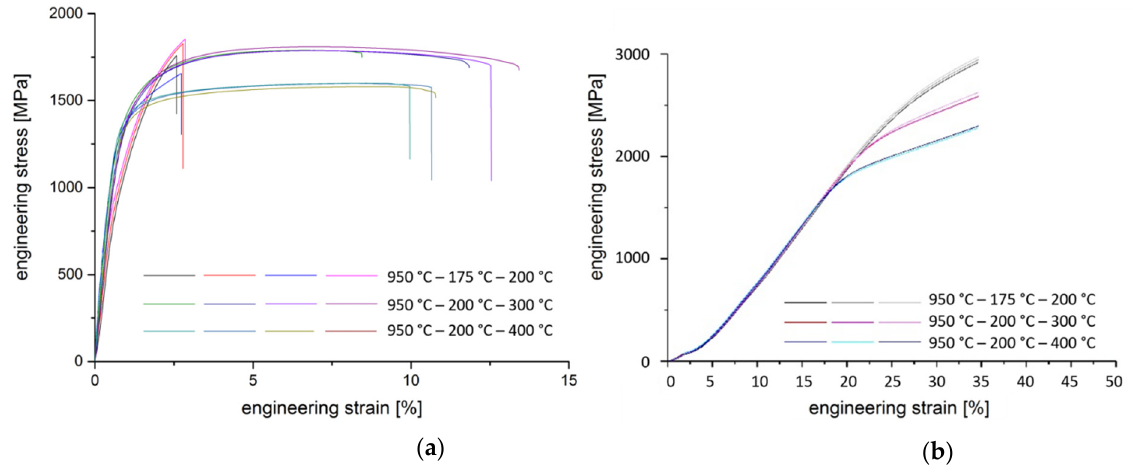
Figure 4. Stress-strain diagrams derived from specimens treated with different Q&P processing routes: ( a ) tensile stress- strain diagram; ( b ) compressive stress-strain diagram. Q&P 1 condition (950 °C–175 °C–200 °C) exhibit the highest yield strength in a and b, but brittle characteristic with almost no plastic deformation. Q&P 2 condition (950 °C–200 °C–300 °C) exhibits high yield strength with a pronounced work hardening and strongly increased total strains in a and slightly de- creased yield strengths under compression load compared to first condition in ( b ). Q&P 3 condition (950 °C–200 °C–400 °C) exhibits high yield strength with a less pronounced work hardening and slightly decreased total strains compared to second condition and lowest yielding under compression ( b ).